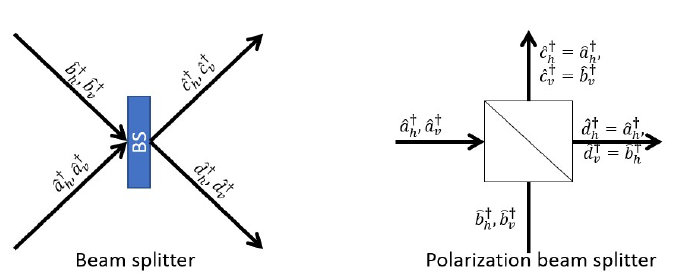
Figure 3. Diagram of ( left ) the beam splitter and ( right ) the polarization beam splitter, acting on the two-rail states with polarization. The equations of (polarization) beam splitters comes from ([20], Equation (6) p. 137 and Equation (7) and p.